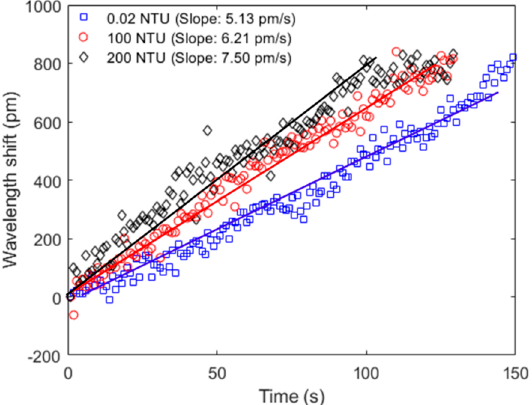
Figure 6. Transient response of the temperature for three different samples. The temperature is estimated using the FBG sensors. estimated using the FBG